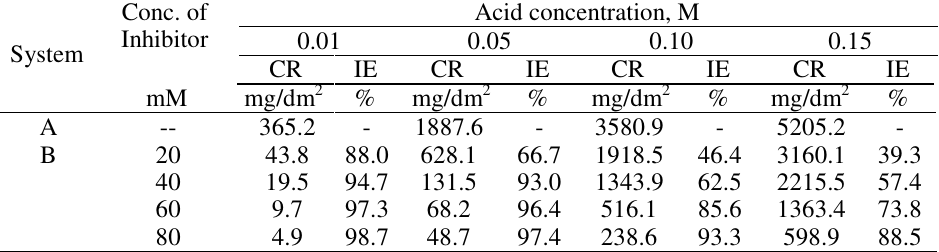
Table 1. Corrosion rate (CR) and inhibition efficiency (IE) of zinc in 0.01, 0.05, 0.10 and 0.15 M H PO acid containing hexamine as inhibitors for an immersion period of 24 h at 301±1 K 3 4